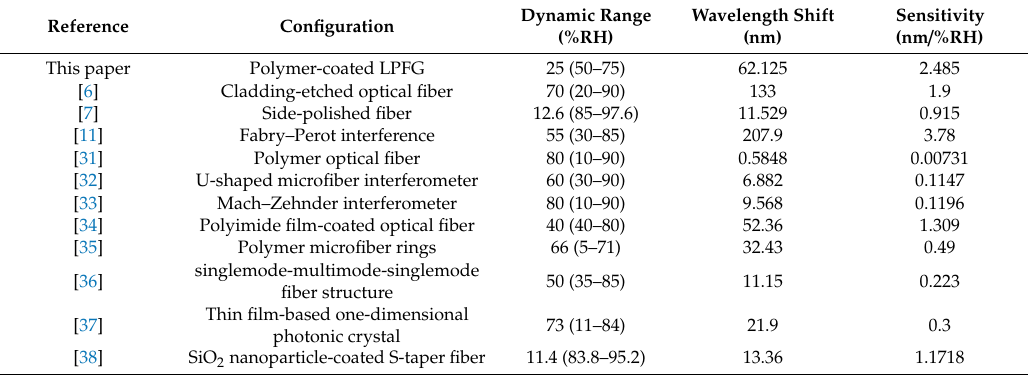
Figure 8. ( a ) Repeatability verification of the first and second experiments. ( b ) The stability test of the proposed PEG/PVA-coated RH sensor. proposed PEG / PVA-coated RH sensor. Table 1. Comparison between wavelength-based fiber optic humidity